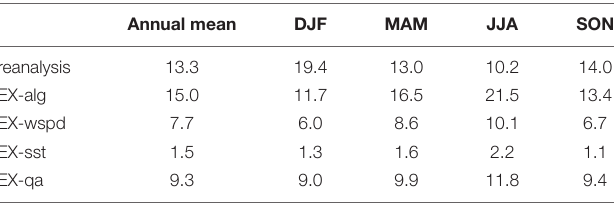
TABLE 1 | Mean absolute deviation of annual and seasonal mean latent heat flux calculated from reanalysis, EX-alg, EX-wspd, EX-sst, and